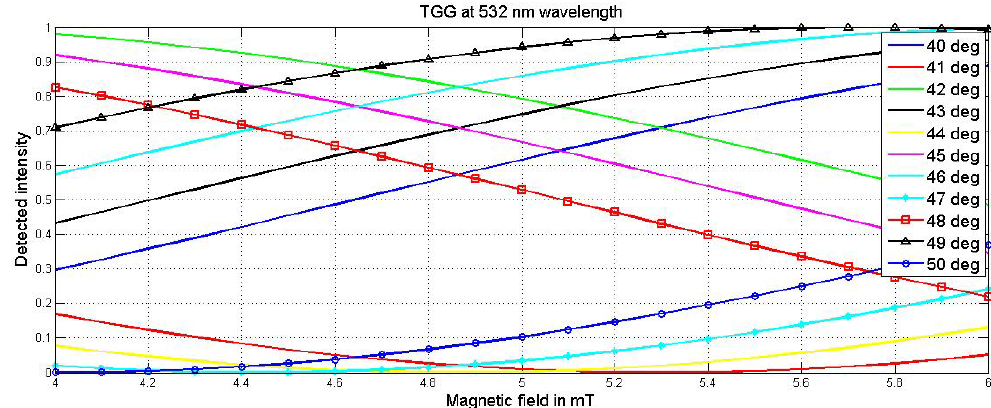
Figure 6. Variation in detected intensity with an analyzer angle from 40 to 50 ◦ of TGG at operating point 5mT.